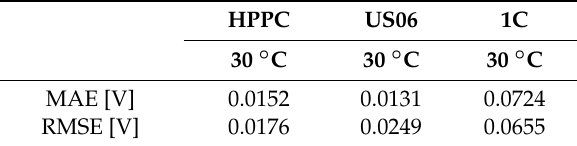
Table 2. MAE and RMSE of the simulated and measured voltage errors.